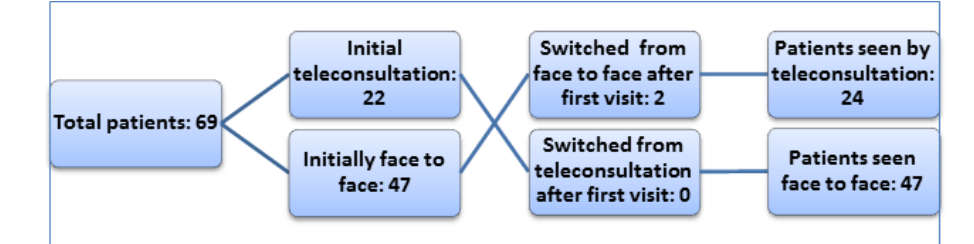
Figure 1. Patient choice of consultation.